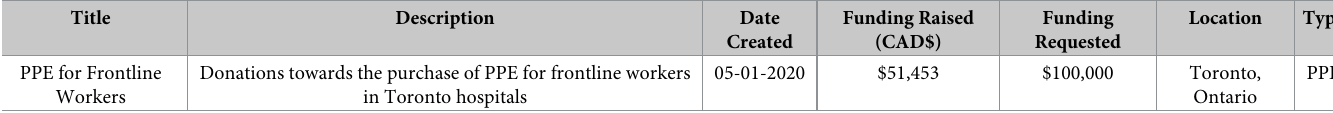
Table 2. Campaign dataset headers and example campaign